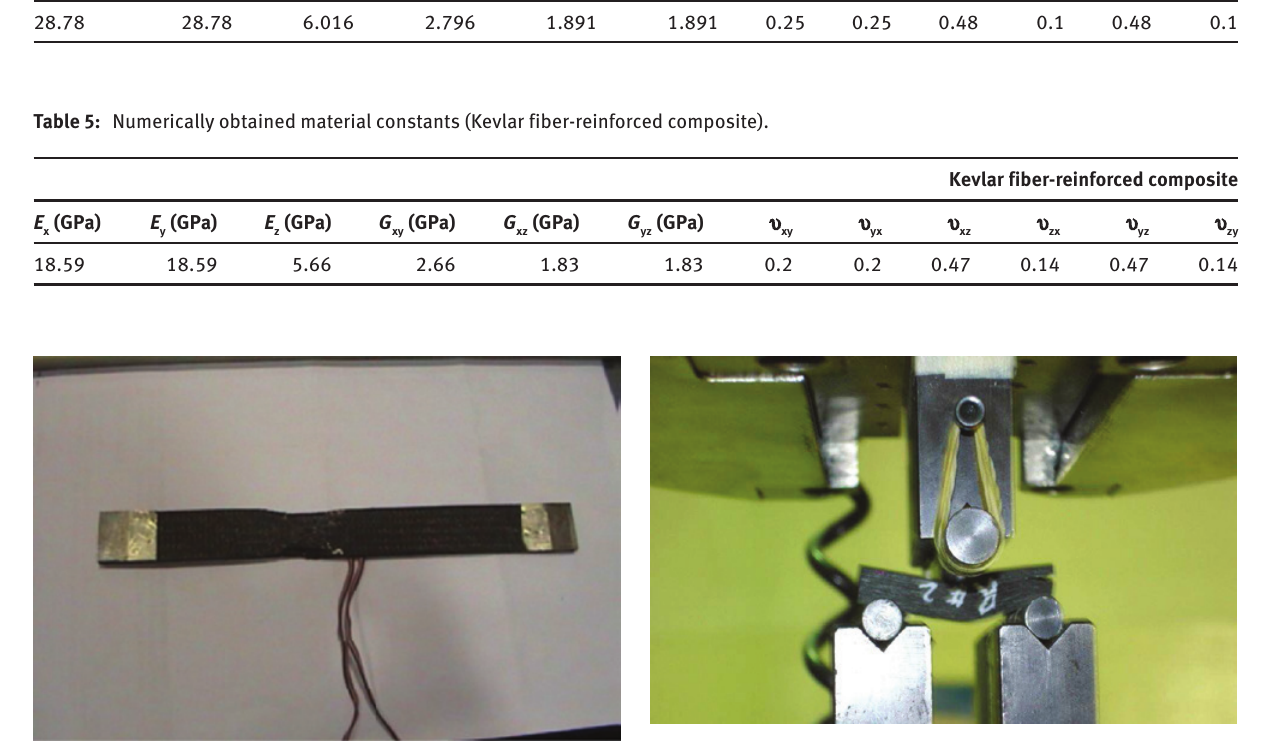
Figure 17: Interlaminar shear stress (ILSS) coupon in UTM.